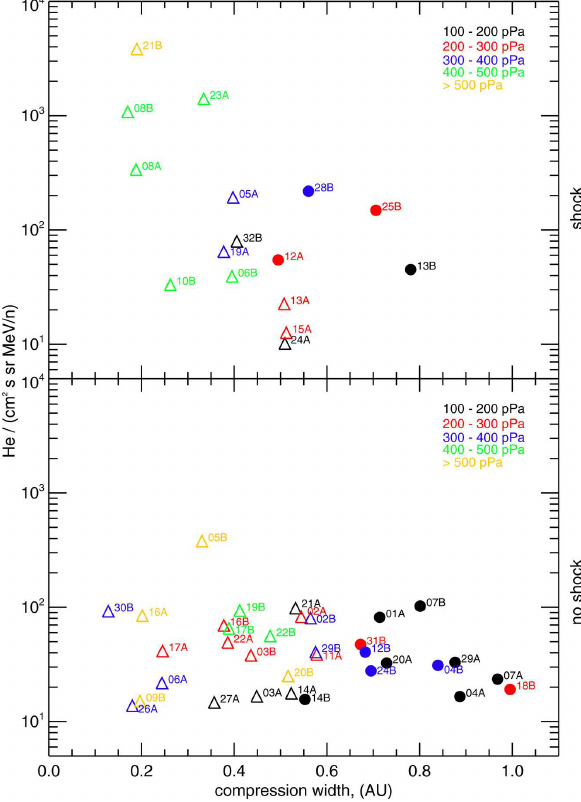
Fig. 3. Peak intensity for 0 . 189MeV / n He vs. compression width. Upper panel: CIRs accompanied by in-situ reverse shocks. Lower panel: CIRs without in-situ reverse shocks. The events with sim- ple streams are marked by triangles; compound streams are marked by circles. Different colors mark different peak pressure over the compression region.